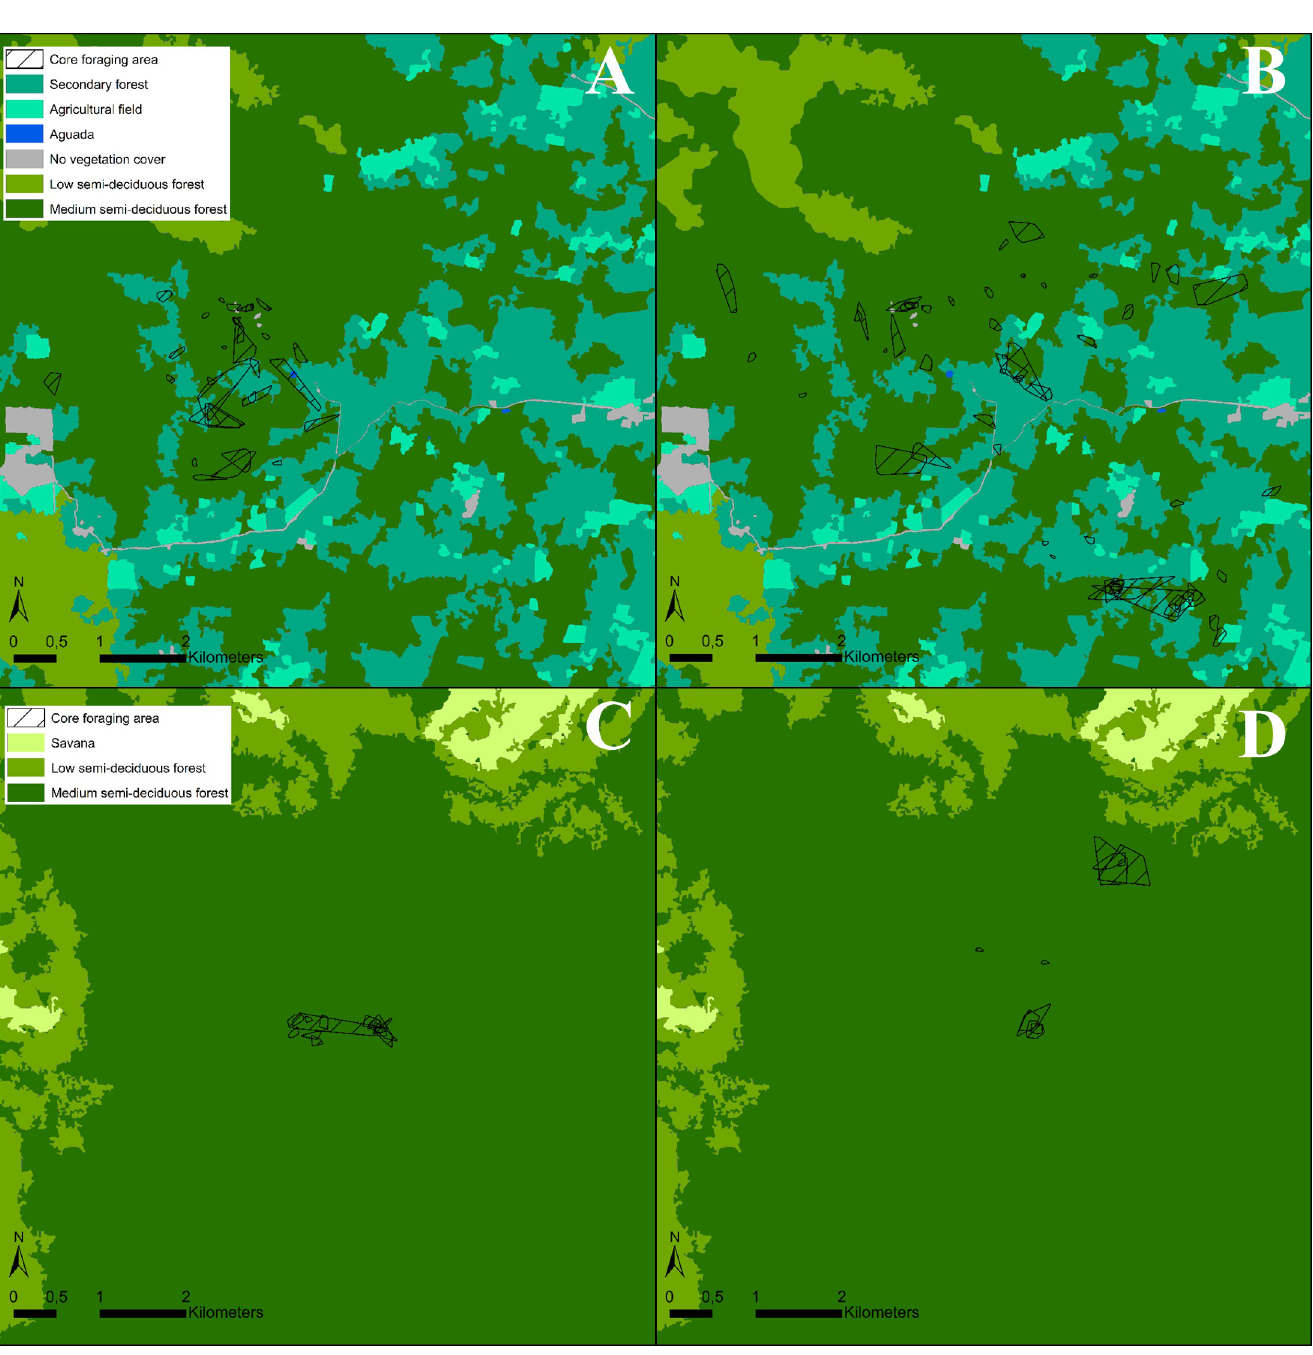
PLOS ONE | https://doi.org/10.1371/journal.pone.0220504 July 29,